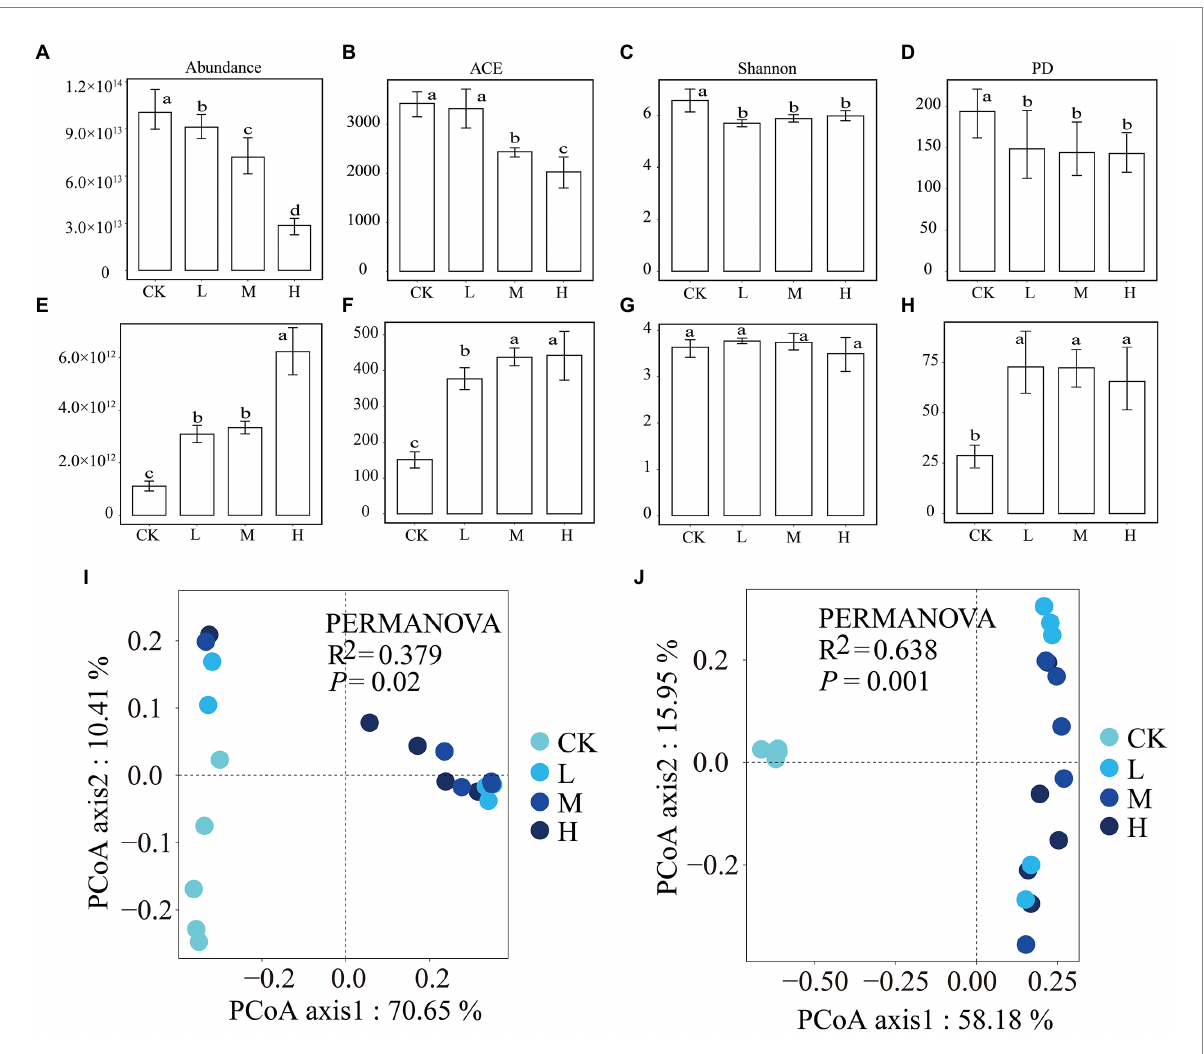
FIGURE 1 Differences in the abundance, alpha diversity, and beta diversity of bacterial and fungal communities among the different RI levels. Abundance of bacteria (A) and fungi (E) ; ACE diversity index of bacteria (B) and fungi (F) ; Shannon diversity index of bacteria (C) and fungi (G) ; phylogenetic diversity index of bacteria (D) and fungi (H) ; and the principal coordinate analysis of bacteria (I) and fungi (J) . Different lowercase letters indicate significant differences among different RI levels ( p <